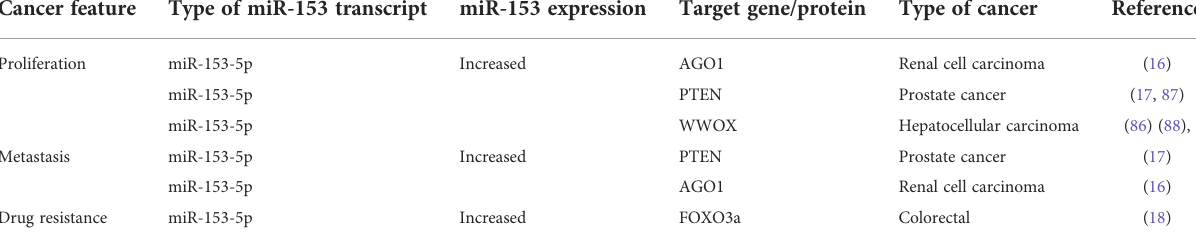
TABLE 2 Oncogenic role of miR-153 in different cancer